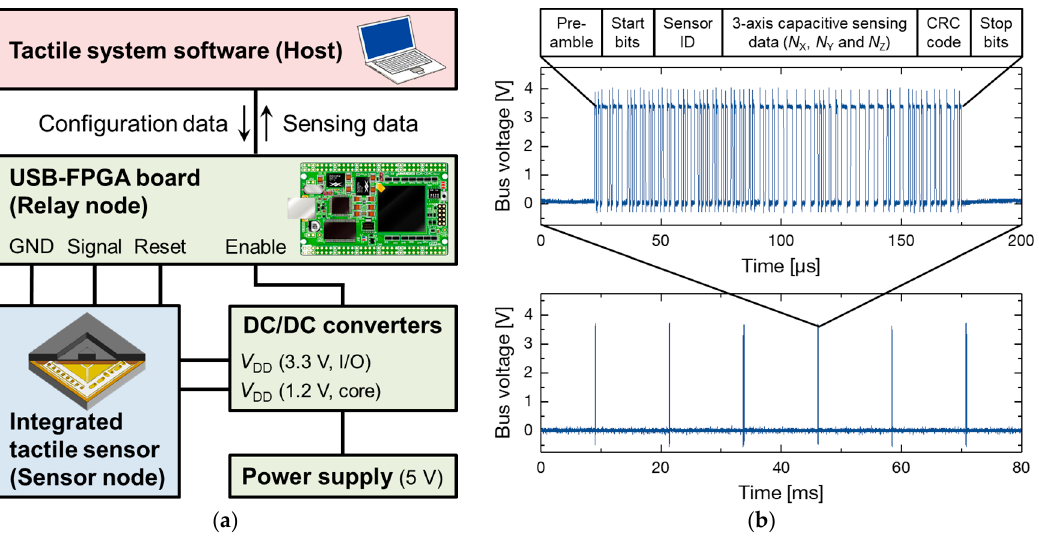
Figure 9. ( a ) Experimental system diagram; ( b ) Digital signal output waveform from the fabricated 3-axis integrated tactile sensor.